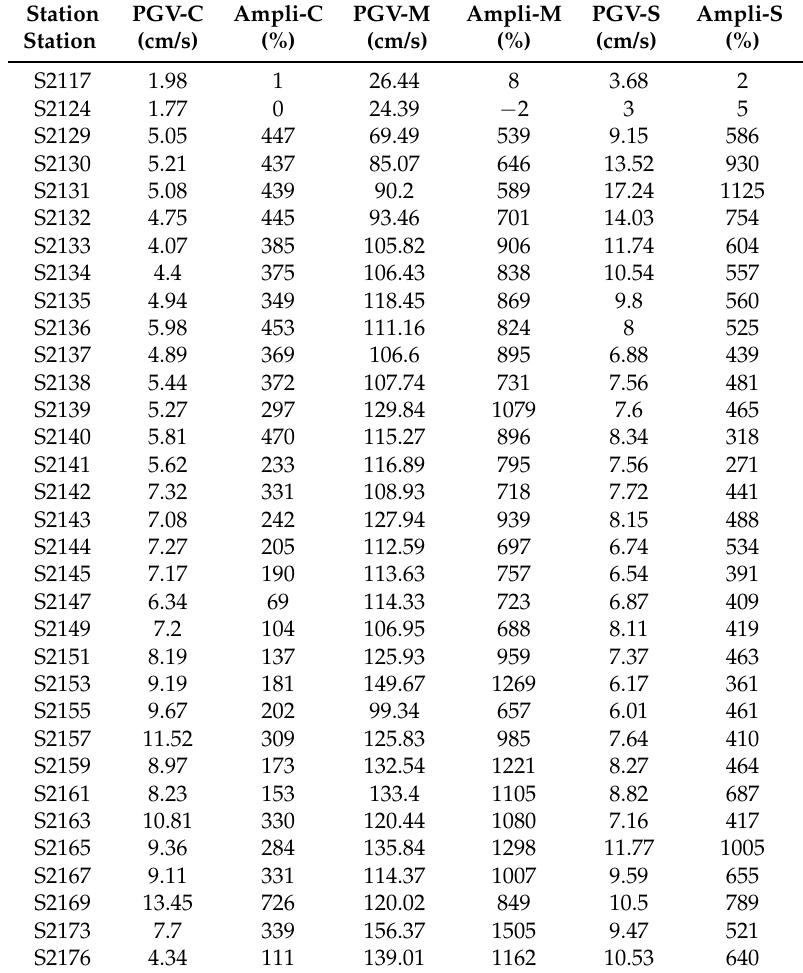
Table 2. PGVs and Amplification in % resulted from 3 scenarios.